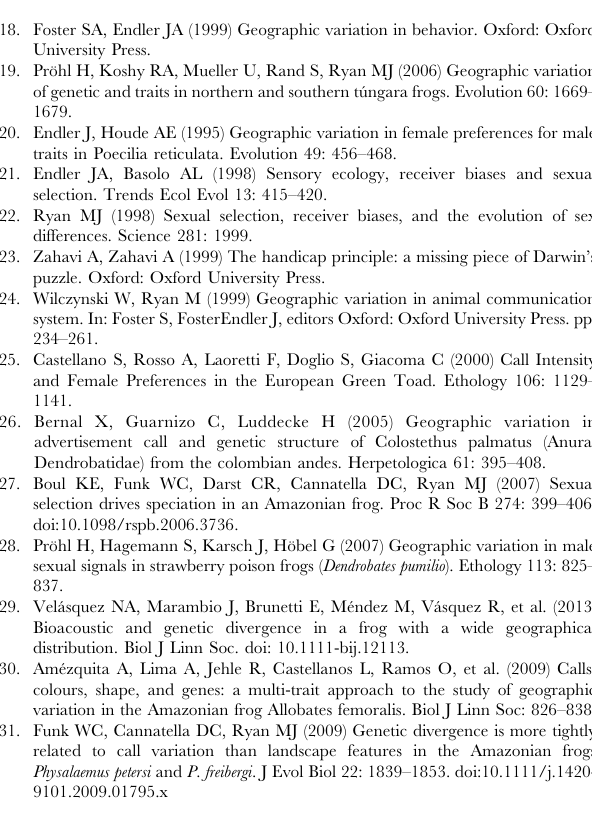
Figure S1 EVR variables measured for males from Totoral to four stimuli series. Name of the stimuli series (Standard, Dominant frequency, Pulse rate and Modulation depth) are indicated at the bottom of the figure. The values of each variant within a stimulation series are shown in the abscissa. Stimuli order corresponds to presentation order 1 (see text). Abbreviations: T, LM and O: standard calls of Totoral, Los Maitenes and Osorno, respectively. Filled circles and bars represent averages and standard errors, respectively. Figure S2 EVR variables measured for males from Los Maitenes to four stimuli series. Name of the stimuli series